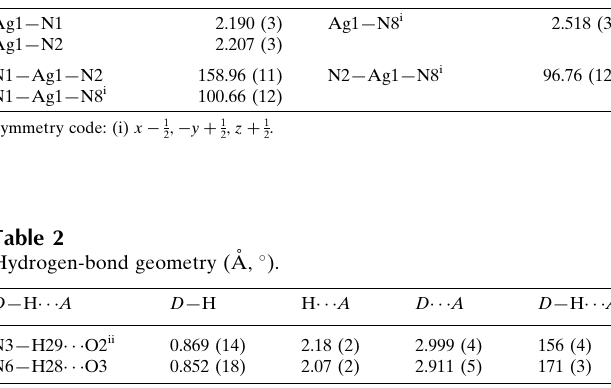
Selected geometric parameters (A˚ , (cid:2) ).